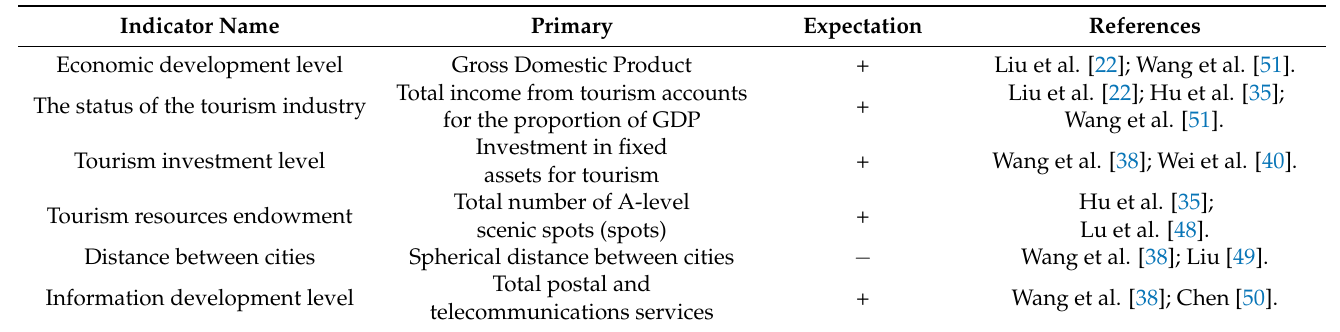
Table 6. Influencing factors for the construction of the index of the spatial correlation network of tourism eco-efficiency.